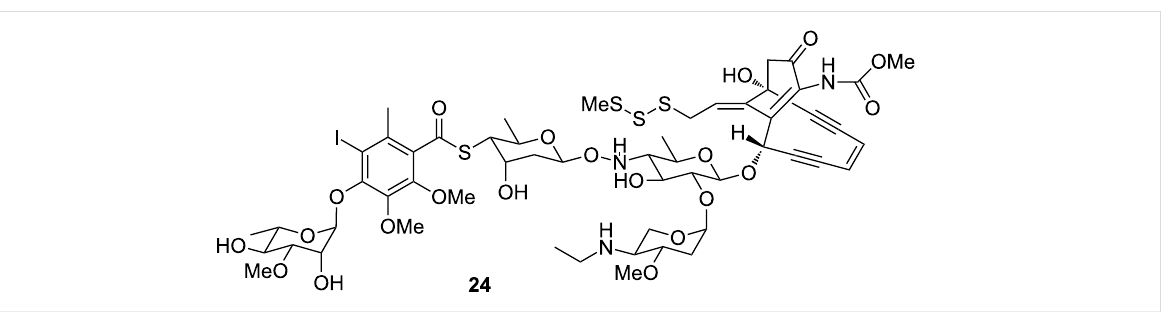
Figure 7: Calicheamicin, a known iodinated compound from the actinomycete Micromonspora echinospora .